Question: What visual encoding does this figure use to show its data?
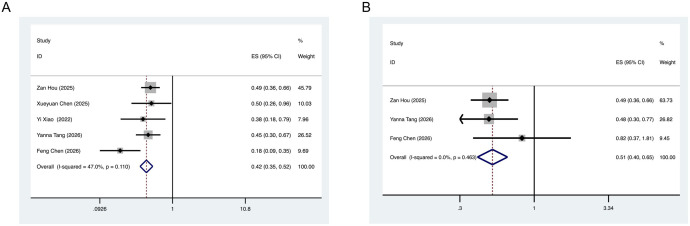
Answer: forest